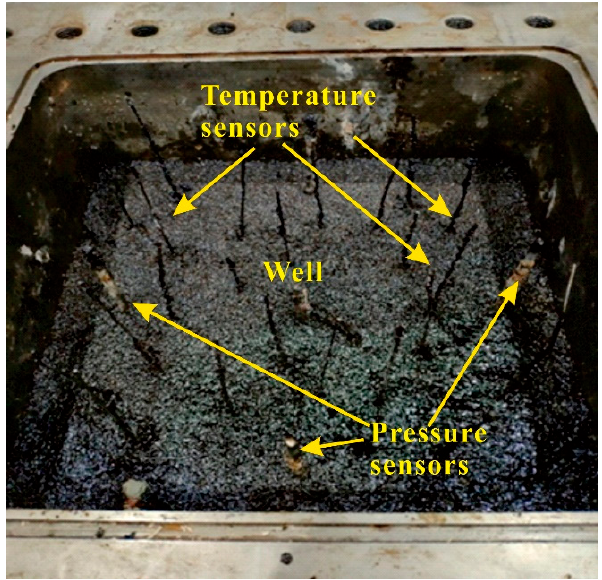
Figure 4. Process of filling the three-dimensional physical model.